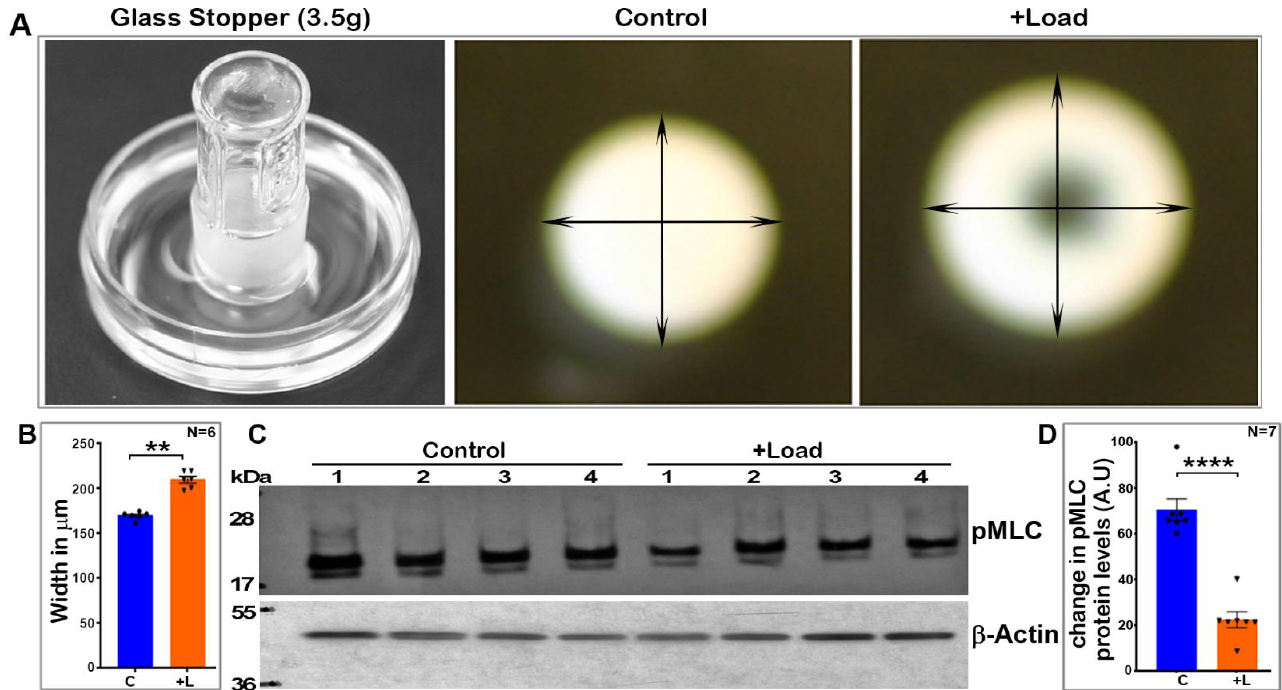
Figure 1. Mechanical-loading-induced lens deformation decreases intracellular myosin II activity. ( A ). To evaluate whether lens shape change induced by external mechanical loading influences myosin II activity, a glass stopper weighing ~3.5 g was placed on freshly enucleated lenses (derived from 4-week-old mice) for 60 s before fixation of the lenses with TCA as described in the Methods section. As shown in panel A (representative images), lenses subjected to mechanical loading exhibited an obvious deformation with a significant increase (by ~24%, n = 6) in width but no rupture, compared to control lenses ( B , C ). Analysis of phosphorylated MLC by immunoblotting revealed a significant decrease (>65%, n = 7) in the levels of phospho-MLC in the load-induced deformed lenses (lanes 1 to 4) relative to their respective controls (lanes 1 to 4) ( D ). Phospho-MLC levels were normalized to β -actin. The levels of β -actin were found to be the same between the deformed and control lenses ( C ). C: Control; L: Load-applied lenses. Values presented as Mean ± SEM. ** p < 0.01; **** p < 0.0001. A.U.: Arbitrary